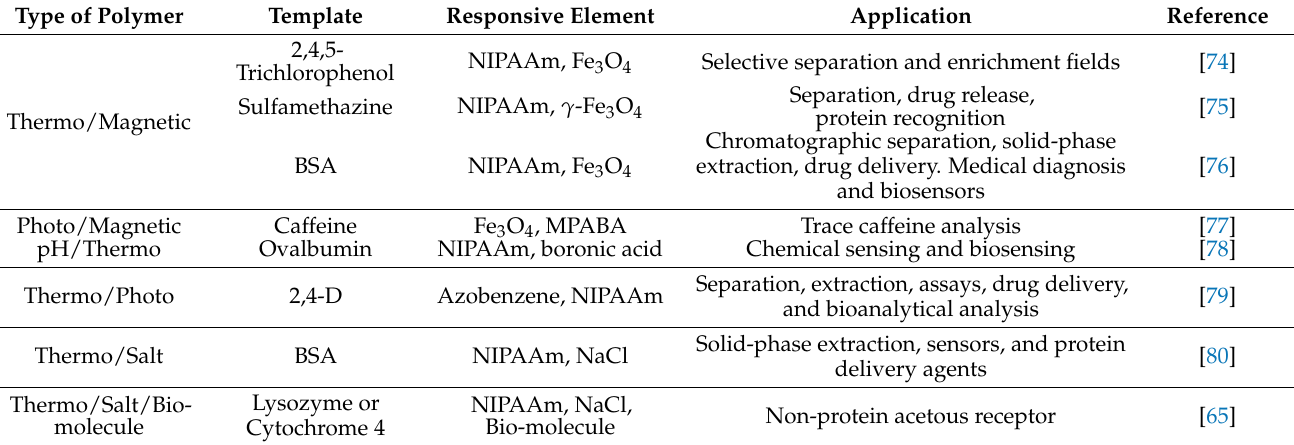
Table 1. Examples of well-reported dual/multiple-responsive MIPs with their applications